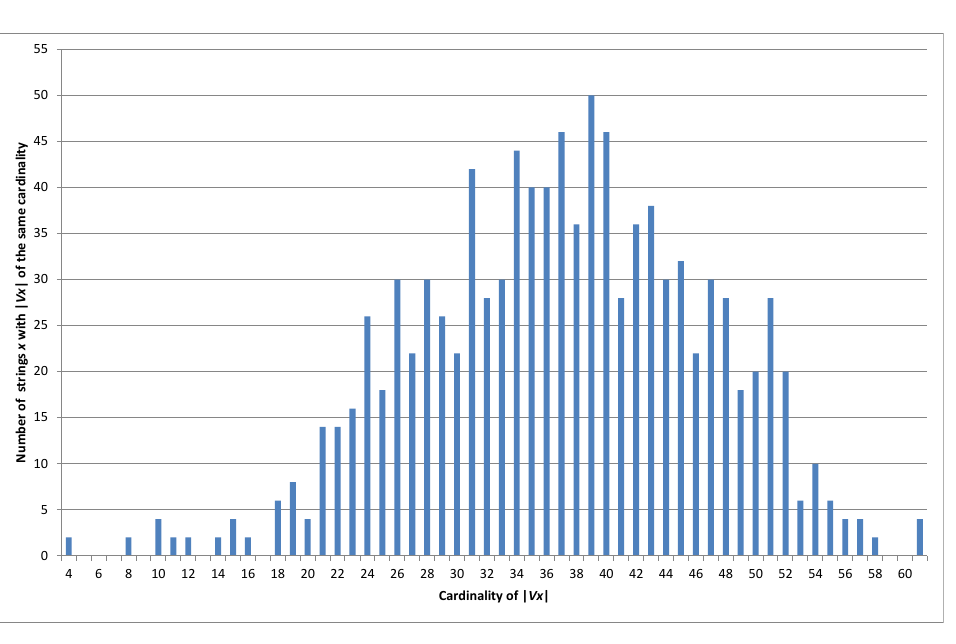
Figure 1. Cardinality distribution histogram for ν = 10. We have estimated the upper bound for max by using the log-linear regression to be 2 0.5122 ν + 0.5253 . As mentioned above, this number is less than 2 ν − 1 . To do this, we collected the data which are included in Table 2. Description of its columns are in the next